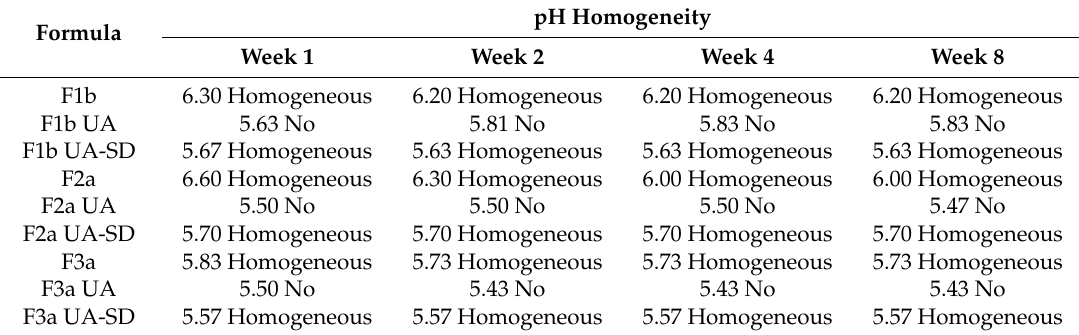
Table 6. Stability test at room temperature.